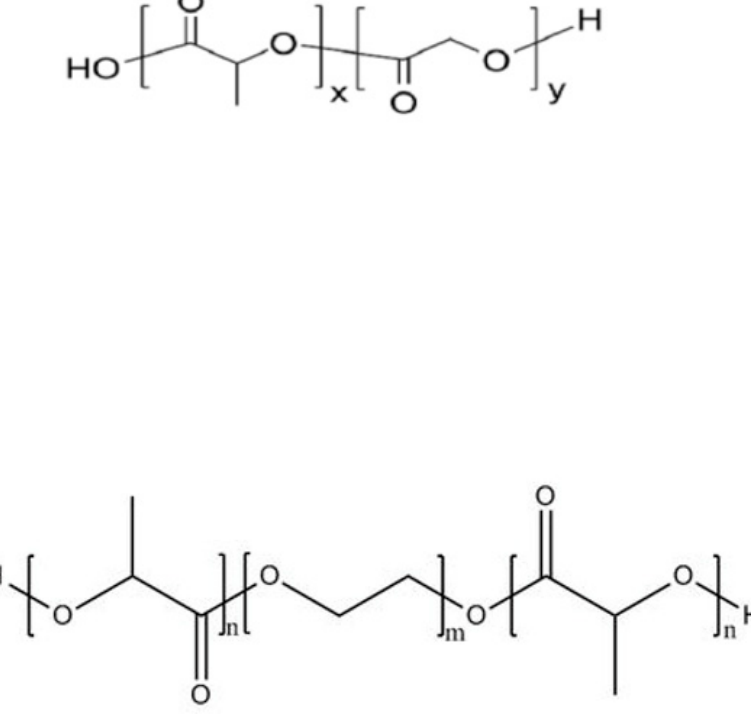
Figure 2. Molecular structure formulas of PLGA (up) and PLA-PEG-PLA (down).